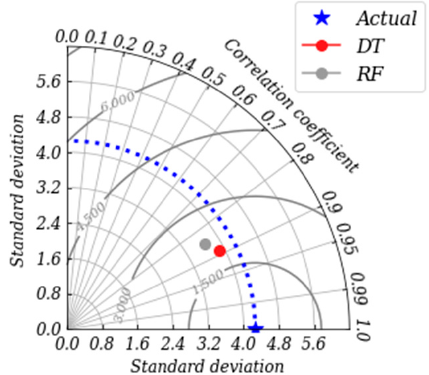
Figure 8. Comparing the accuracy of the proposed models through a Taylor diagram.